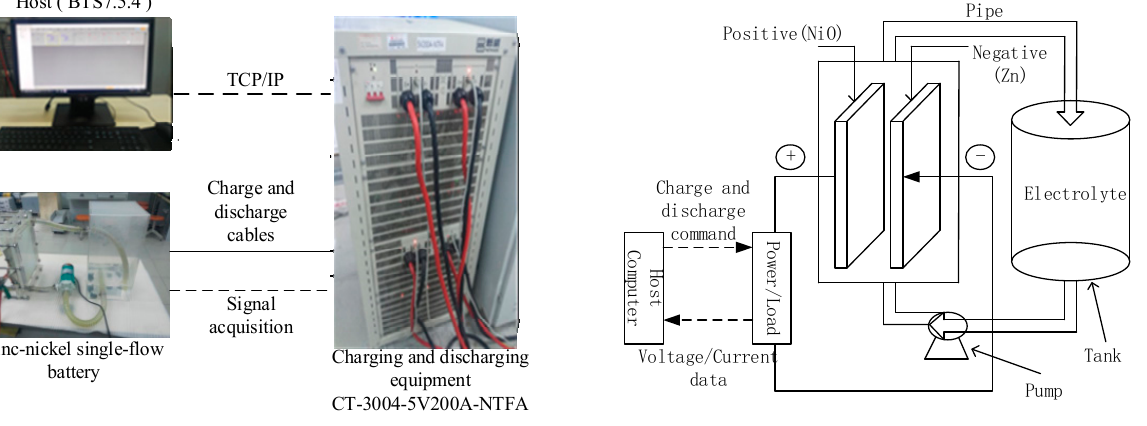
Figure 2. The composition of the experimental platform. Parameters to be identified in this model are R 0 , R 1 , C 1 , R 2 , C 2 , and U oc . A constant current pulse condition is used in this study. The battery is charged with 1 C (16 A) to achieve the capacity of 16 Ah, and then a 0.75 C (12 A) constant discharging current pulse is loaded to the battery over every 5% SOC drop interval. A relaxation period of 20 min